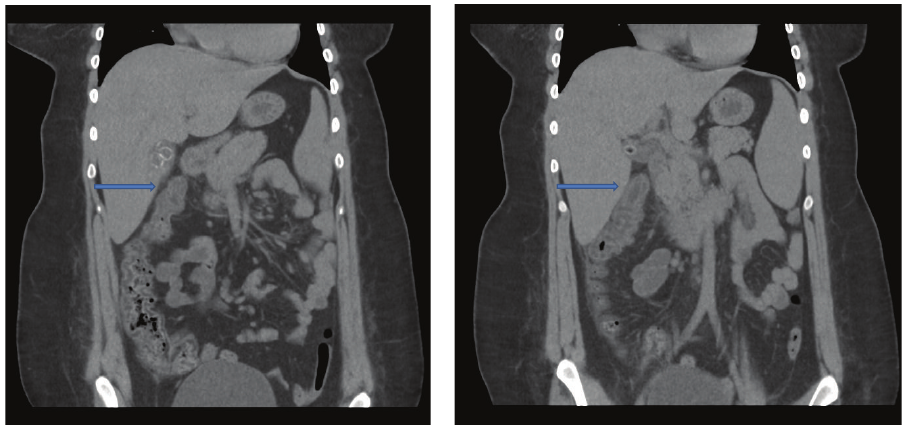
Figure 2: CT abdomen after C1 INH treatment, demonstrating resolution of intussusception